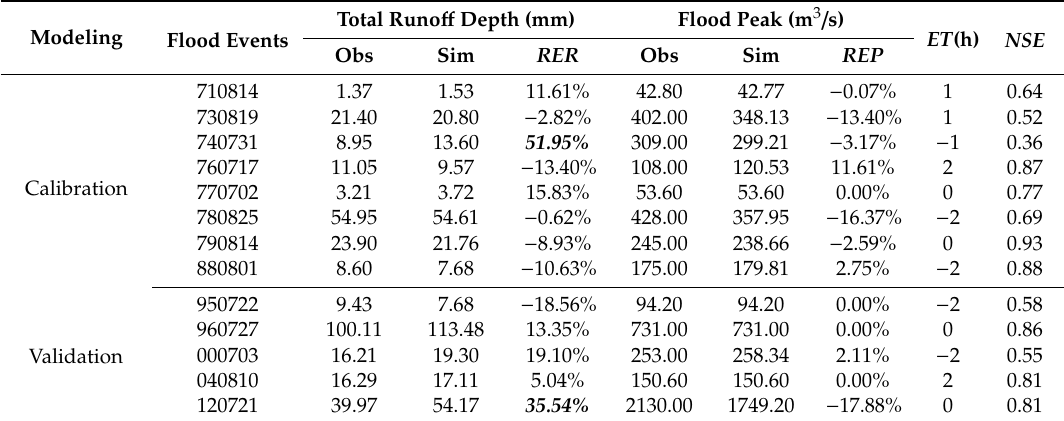
Table 1. Observation, simulation and performance evaluation measures by SVHM model in Zijingguan Basin. Total Runo ff Depth (mm) Flood Peak (m 3 / s) Modeling Flood Events